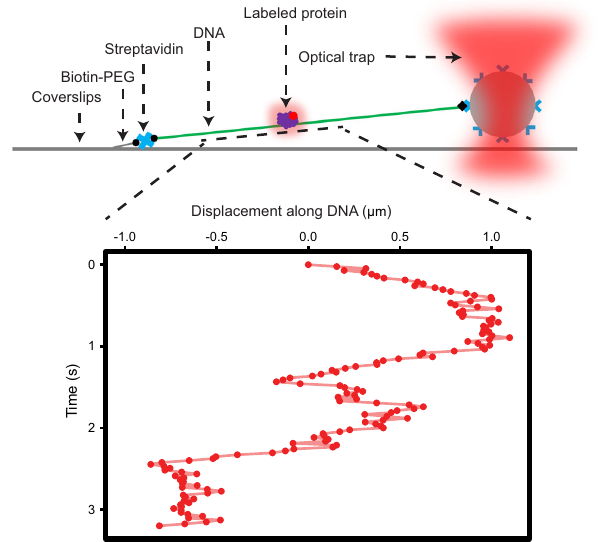
Fig. 1 DNA-scanning experimental setup. Using a streptavidin linker, a biotin-tagged DNA is attached to a biotin-tagged PEG molecule that is bound to the surface of a coverslip. At the other end, the anchored DNA is attached to a polystyrene bead using an anti-digoxigenin and digoxigenin link. DNA is elongated by trapping and moving the attached polystyrene bead using an optical trap. Movements of fl uorescently labeled proteins along the linear track of DNA is recorded, as exempli fi ed in the time- position plot in the lower